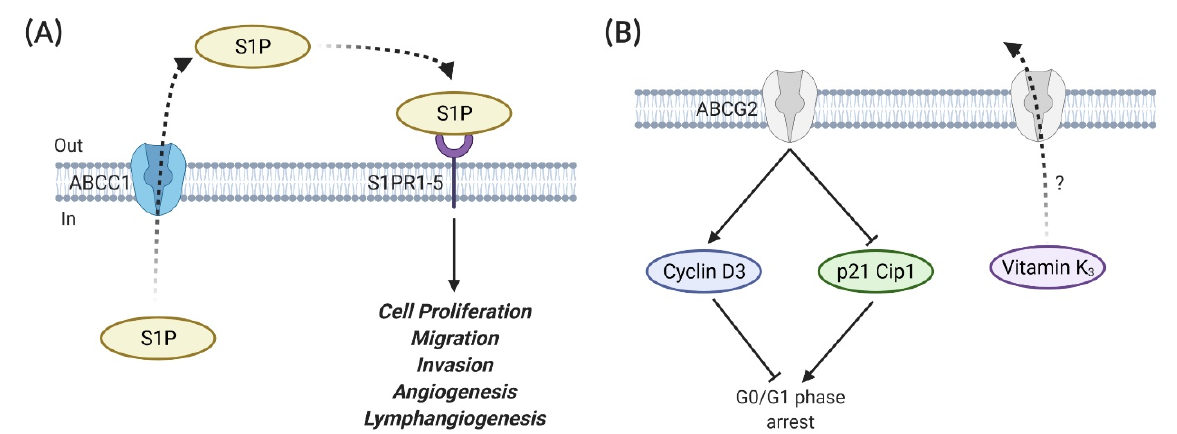
Figure 4. The role of ABC transporters in in vitro proliferation. ( A ) ABCC1 is involved in the export of sphingosine-1- phosphate (S1P). The binding of extracellular S1P to a family of G protein-coupled receptors (S1PR1-5) facilitates cell proliferation, migration, invasion, angiogenesis and lymphangiogenesis [99,100]. ( B ) ABCG2 inhibits G0/G1 arrest through the upregulation of cyclin D3 and downregulation of p21 Cip1. ABCG2 may also participate in the cell cycle via the translocation of endogenous substrates that relate to the cell cycle, such as vitamin K 3 [98]. Figures were created with BioRender.com (accessed on 22 March